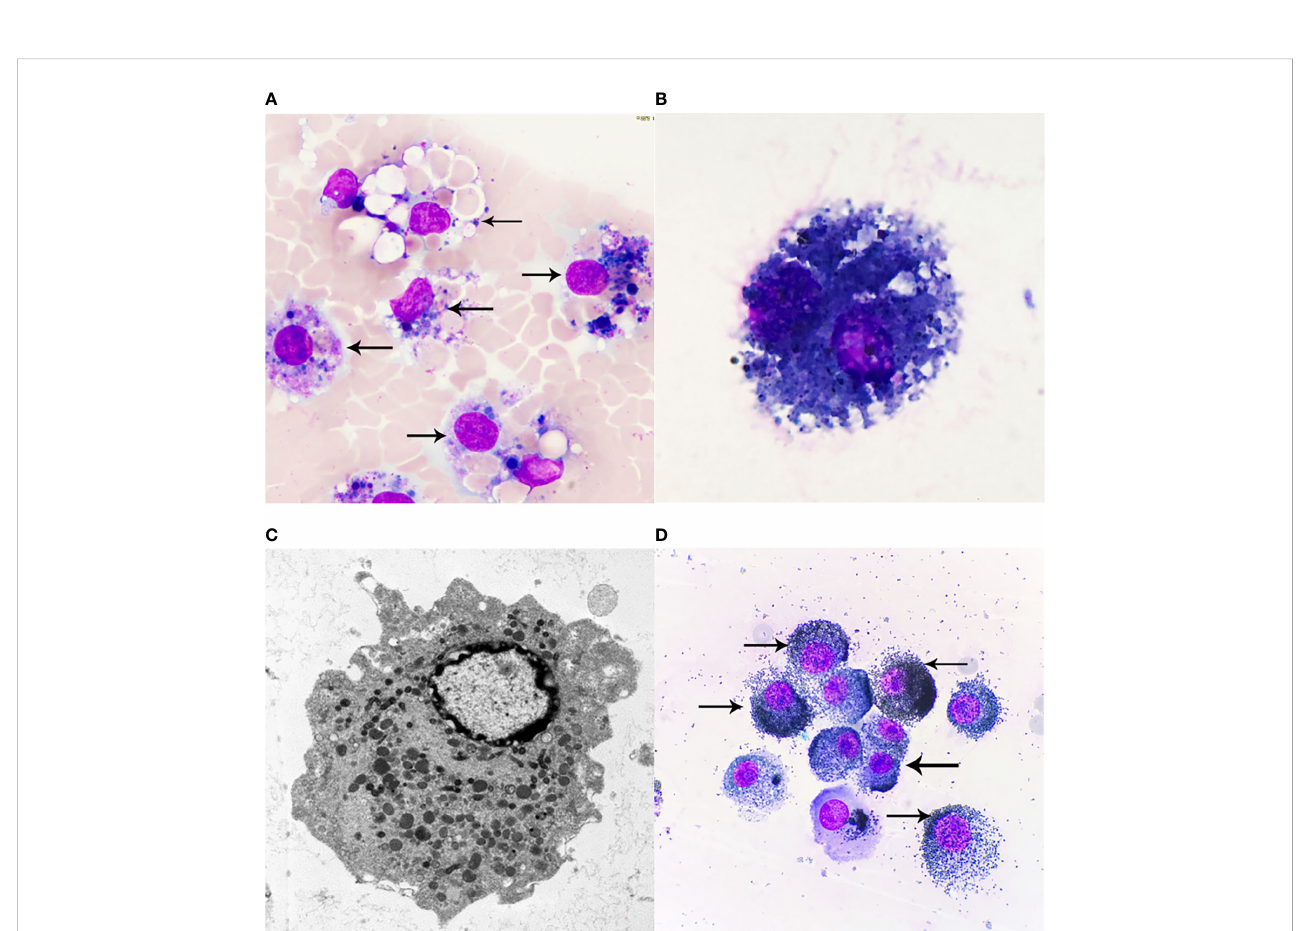
FIGURE 3 (A) Hemosiderin cells, Wright-Giemsa Stained ×1000. Macrophages engulffresh red blood cells or red blood cell fragments, and after Wright-Giemsa Staining, intracytoplasmic digestion can be seen to form vacuole areas, and blue or blue-black hemosiderin granules of different sizes can also be seen, that is, hemosiderin cells. (B) Dust cells, Wright-Giemsa Stained ×1000. Macrophages that mainly engulf substances that cannot be broken down, such as dust. Black particles and droplets of blue lipids formed by tar can be seen. (C) Electron microscopy of macrophages ×10000. Macrophages are diverse in morphology and vary due to their different functional states, generally round or oval in shape, with short protrusions, and those with active functions often extend longer pseudopodia and are irregular. The nucleus is small, round or oval in shape, and darkly colored. Under transmission electron microscopy, the cytoplasm contains a large number of primary lysosomes, secondary lysosomes, phagocytosic vesicles and phagosomes, in addition to the more developed Golgi complex, a small number of mitochondria and a rough endoplasmic reticulum. (D) Melanoma cells, Wright-Giemsa Stained ×1000. Melanoma cells have moderate to rich cytoplasm and eccentric nuclei, and cell morphology is characteristic of malignant tumor cells, chromatin is loose, and melanoma cells have fi ne, uniform granules; melanin particles can be found in the cytoplasm of tumor cells or melanoma macrophages. The arrows of (A) refer to more typical Hemosiderin cells, the arrows of (D) refer to more typical Melanoma cells.